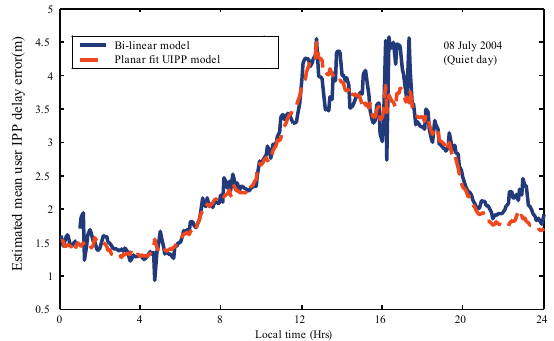
Fig. 5. Estimated mean UIPP delays due to the bilinear interpolation technique and planar fit model (23 July 2004)